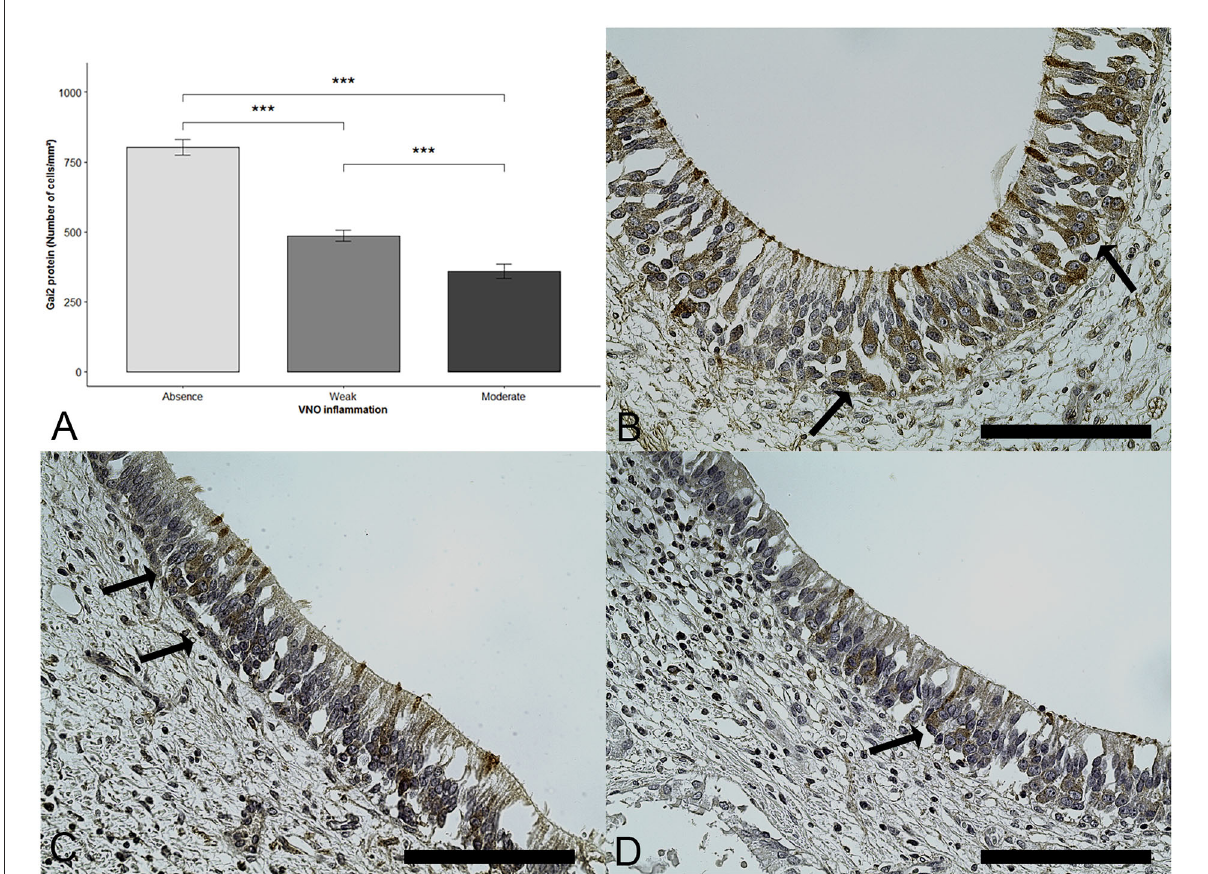
FIGURE3 G α i2 + cells number decrease with inflammation intensity. Immunohistochemical staining was used to reveal the presence of G α i2 protein (brown staining shown by arrows). (A) Mean and standard error of the G α i2 protein according to the vomeronasal organ inflammation. Data are expressed in number of G α i2 + cells /mm 2 and shown as the mean ± SE (*** = p < 0.001). (B) Healthy epithelium, score = 0, (C) Weak inflammation, score = 1, (D) Moderate inflammation, score = 2. (Objective x40, Scale bars 100 µ